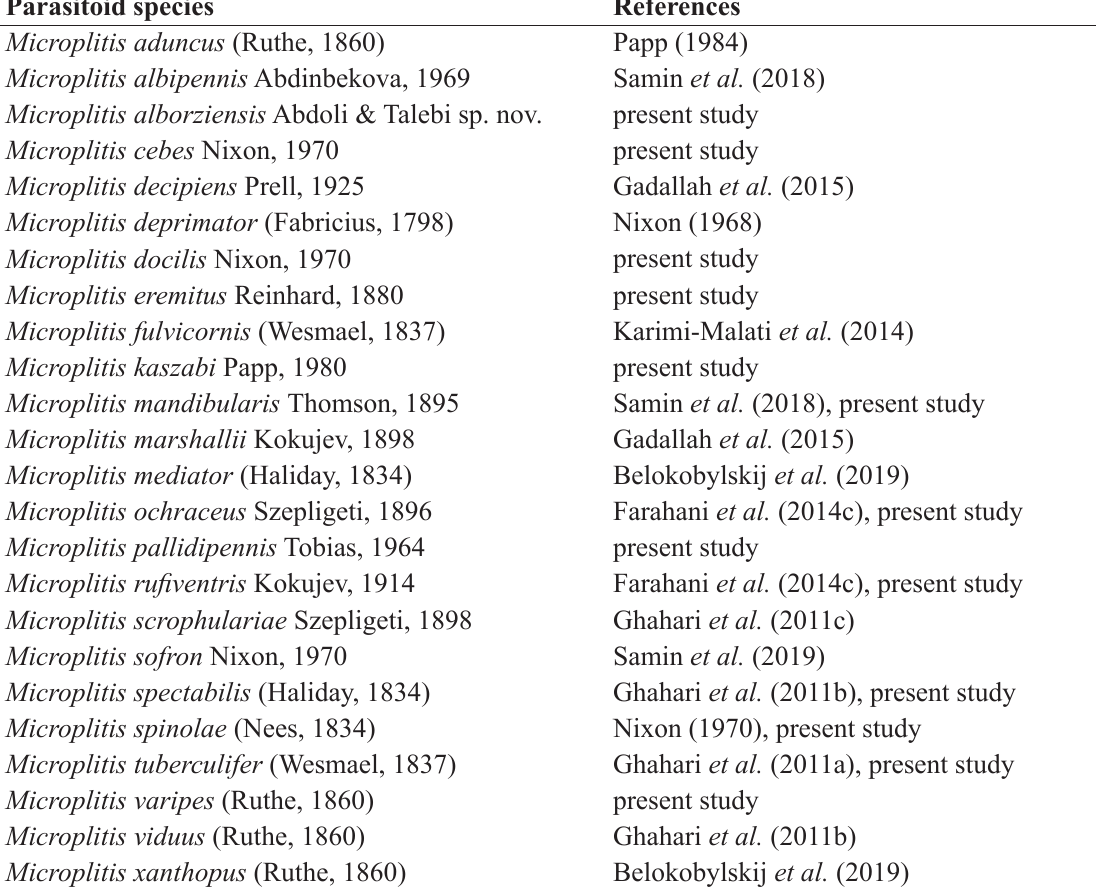
Table 1. Updated list of the species of Microplitis Förster, 1862 (Hymenoptera: Braconidae, Microgasterinae) recorded from